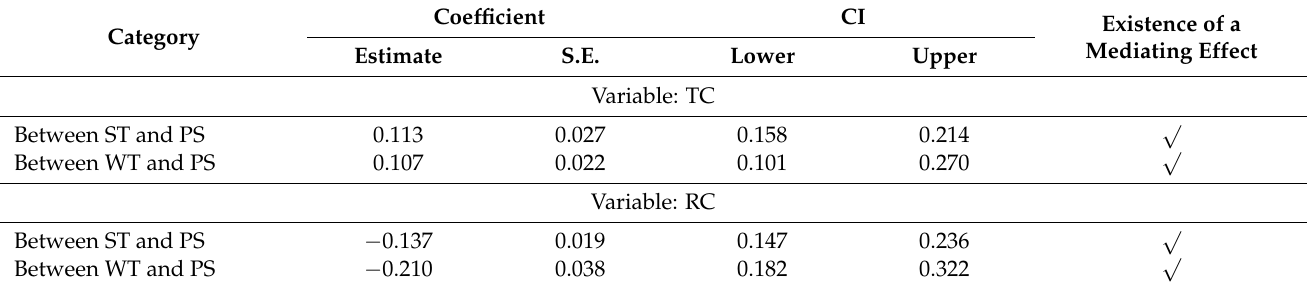
Table 5. Mediating effect test.